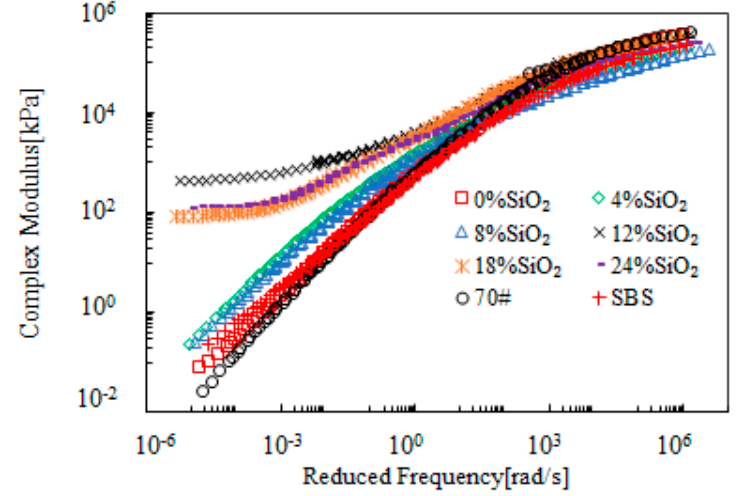
Materials 2019 , 12 , x FOR PEER REVIEW Figure 11. Master curves of the complex modulus of SiO 2 -modified bitumen emulsion.